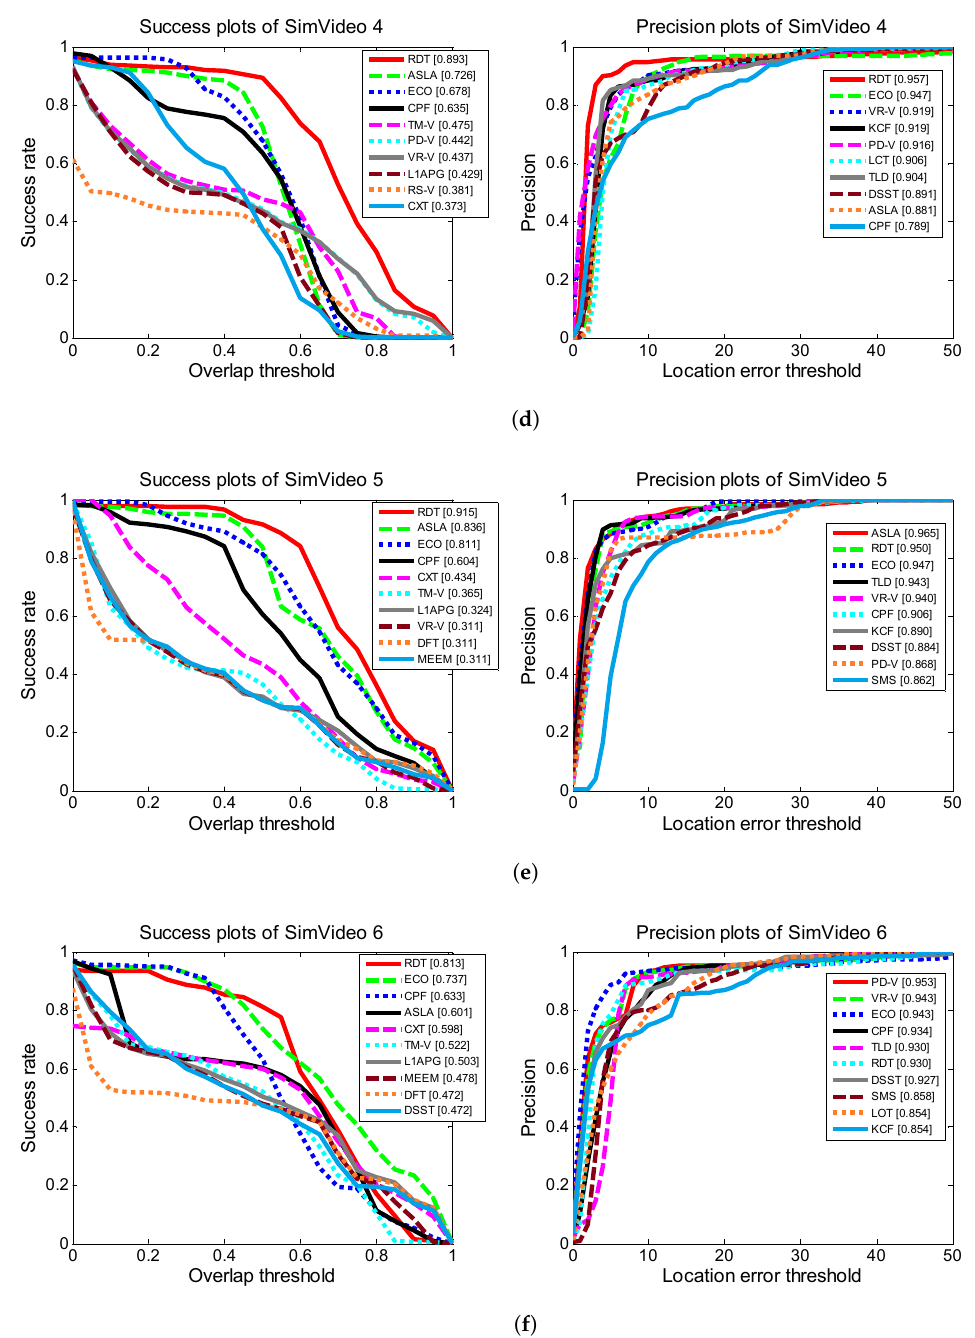
Figure 20. Success plots and precision plots of simulated infrared sequences. The corresponding results of different simulated infrared sequences are shown in